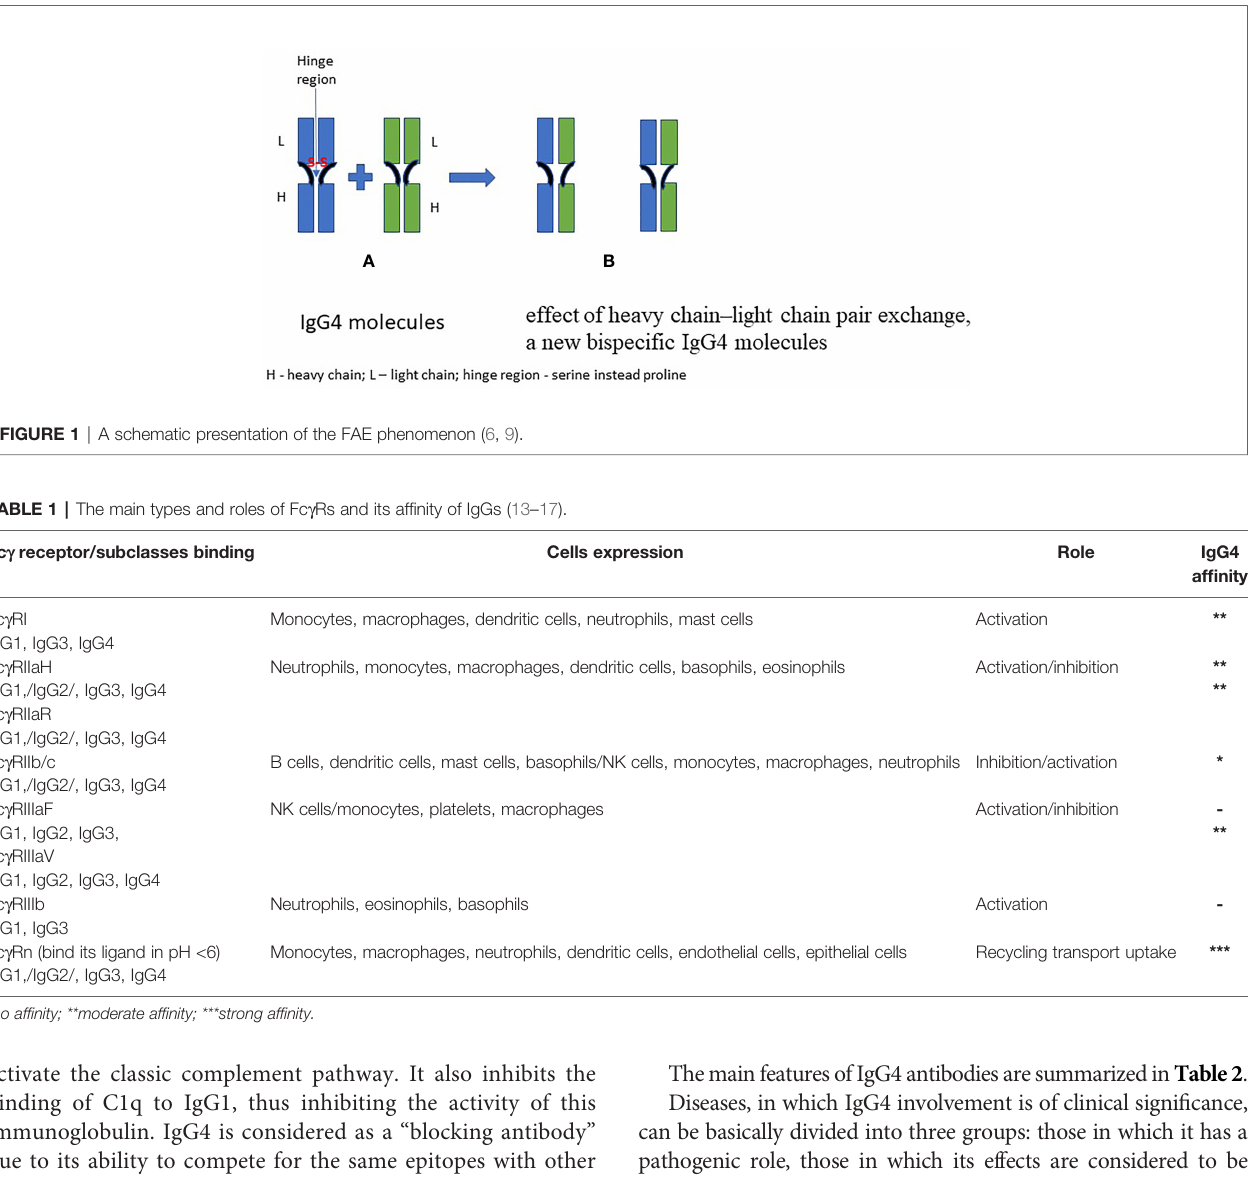
Activation/inhibition